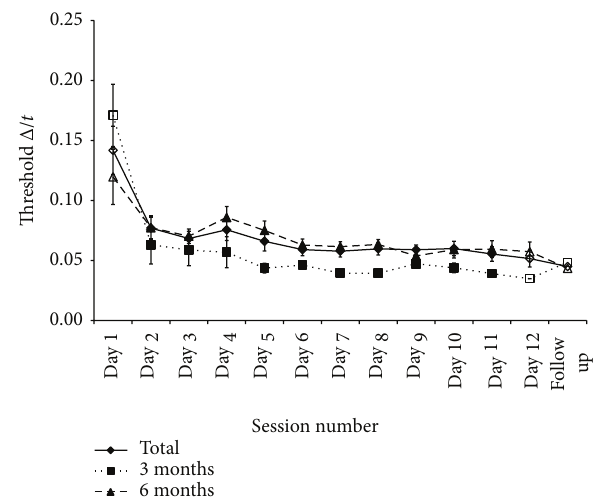
Figure 5: Learning curves showing mean temporal-interval dis- crimination thresholds ( Δ t / t for 79% correct performance) on the trained standard interval (90ms, 1kHz, −85 dB). The filled line represents the full data set for this experiment with the dotted line showing the curve for the “3 months since experiment 1 posttest” group and the dashed line for the “6 months from experiment 1 posttest” group. Filled symbols represent test phases (pre-test, posttest, follow-up) with empty symbols being training days. Whilst not displayed to scale, the first 12 sessions all took place within 3 weeks of the pretest session with the “follow- up” session undertaken either 3 or 6 months after the posttest session. Error bars indicate ±